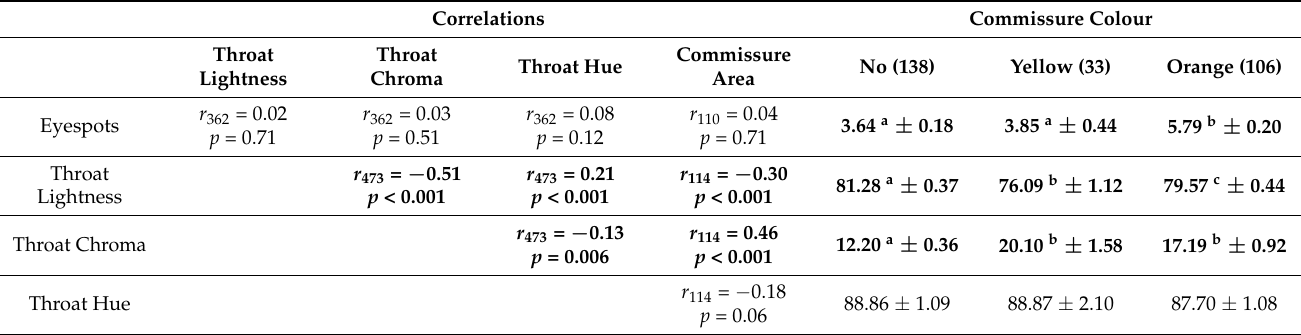
Table 1. Correlations among the continuous variables (provided sample size -in the subscript-, correlation coefficient and p -value are provided), and average values ( ± SE) for each category of commissure colour (no colour, yellow, or orange). Sample sizes for each category of commissure colour between brackets (for eyespots of lizards with orange commissures, the sample size was 103). Raw data are shown, but statistical tests were carried out with transformed variables when necessary. In bold significant relationships or differences. Different superscripts indicate significant differences according to an unequal N HSD post hoc test.